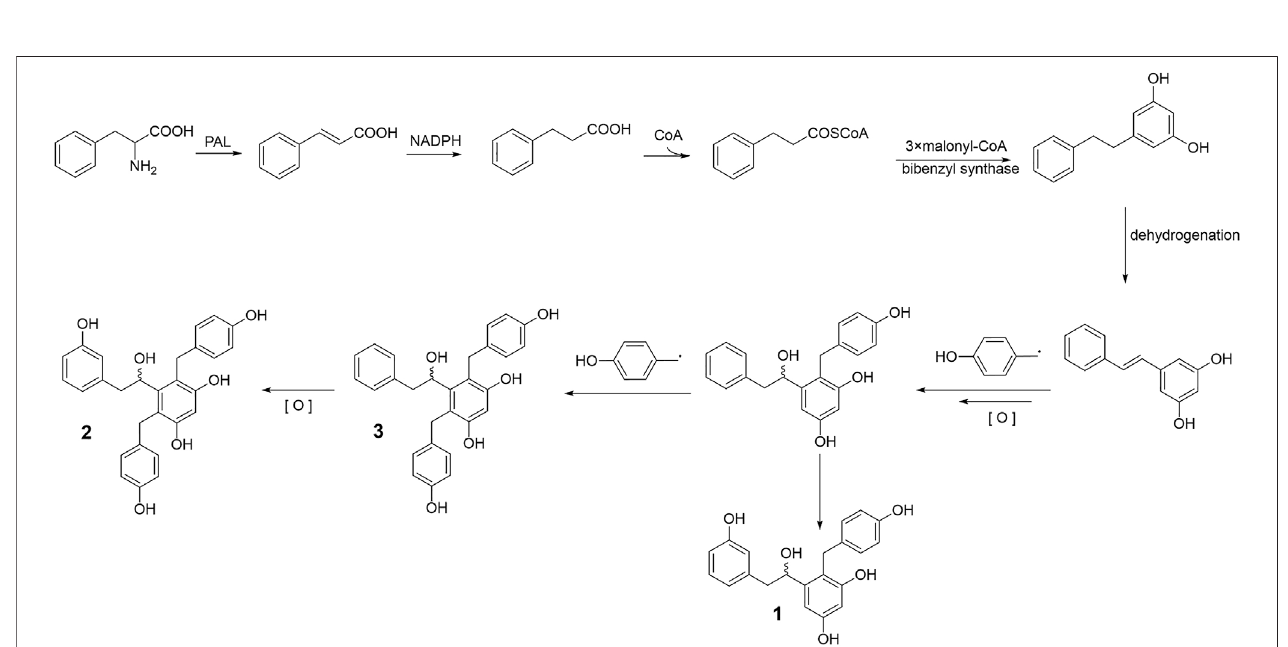
FIGURE 4 | Plausible biogenetic pathway of compounds 1 – 3.